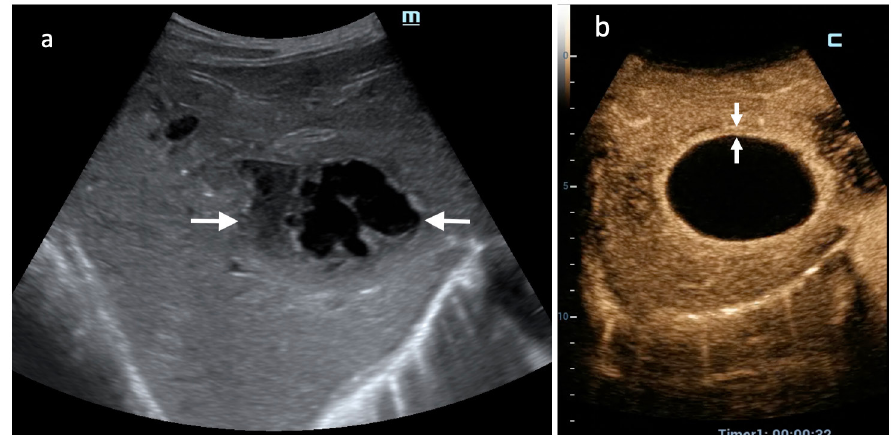
Figure 7. CEUS PLA type IV. (a) A complex mass of the right liver lobe (between white arrows) seems liquified only in part; (b) in the arterial phase the entire mass is non-enhanced, hence totally colliquated. Note the uniform PHR (between white arrows)